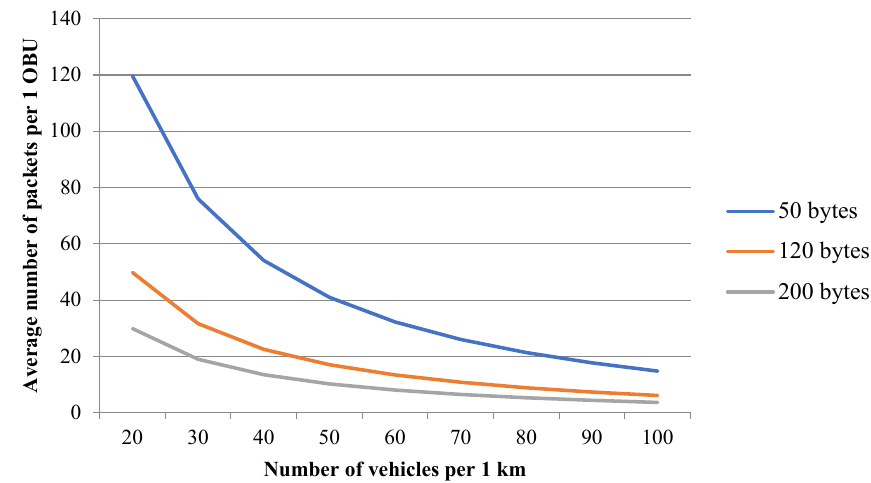
Figure 8. Average number of packets per OBU when using confidentiality level 2.